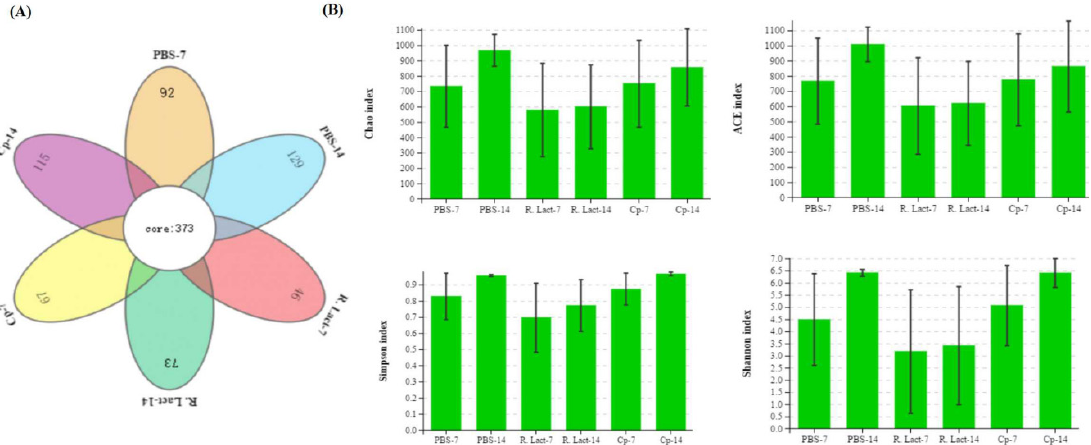
Figure 9. Microbial community configuration of various groups: ( A ) Venn diagram of OTUs. ( B ) Four metrics of analysis, Chao, ACE, Simpson, and Shannon indices, for alpha-diversity among all groups, namely PBS-7, PBS-14 control groups, R. Lact-7, R. Lact-14 recombinant L. crispatus groups, and Cp-7 and Cp-14 C. perfringens